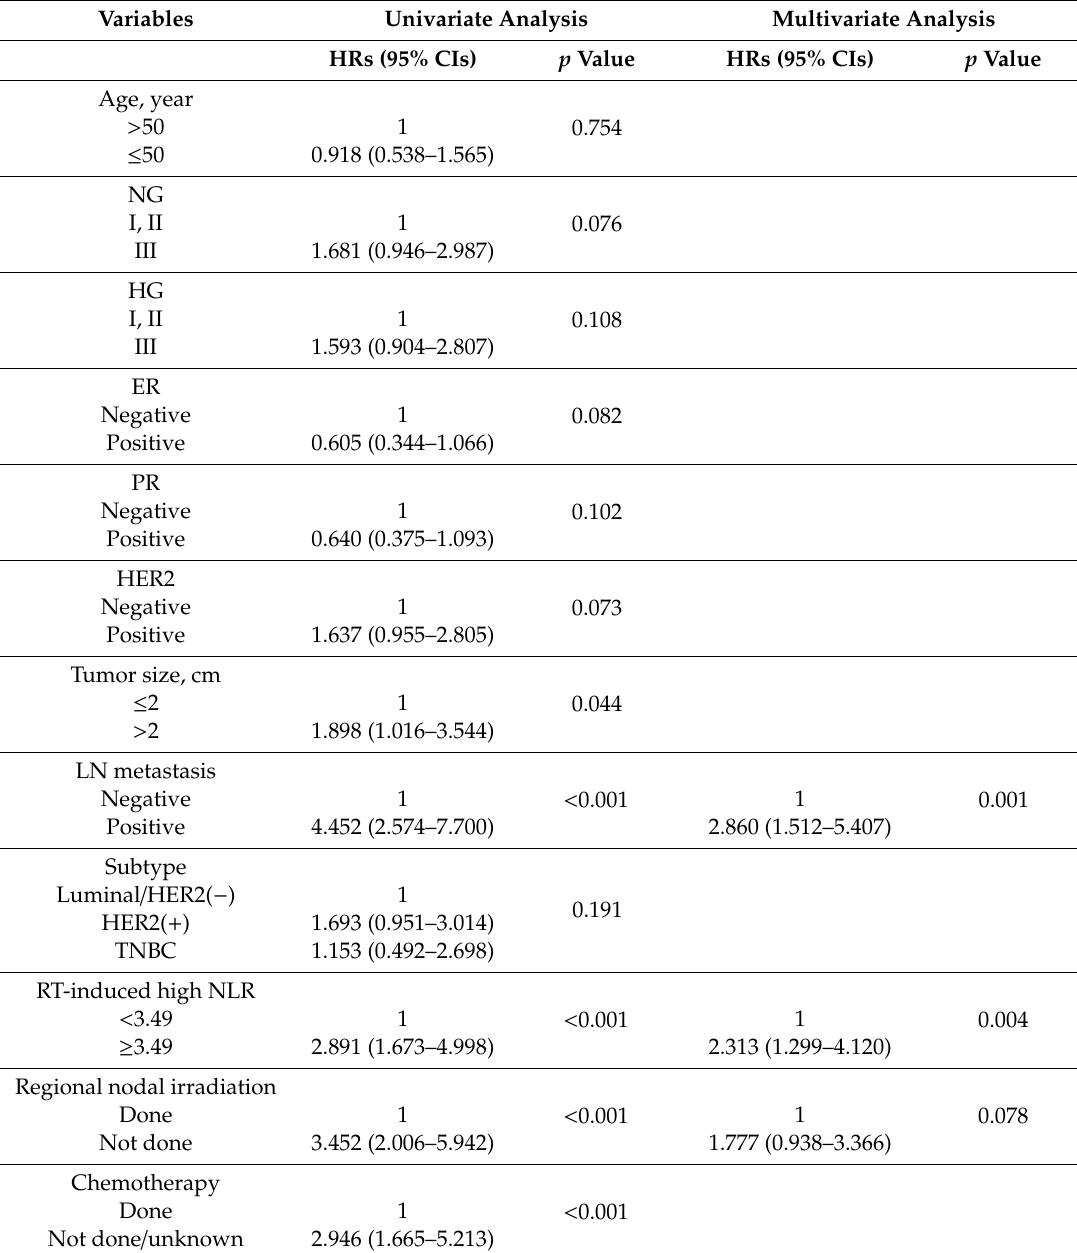
(Table S2; HR: 2.643, 95% CI: 1.335–5.236, p = 0.005) in the univariate analysis. Similar trends were seen in the multivariate analysis (Table S2; HR: 2.394, 95% CI: 1.106–5.181, p = 0.027). RT-induced high NLR was an independent prognostic factor along with lymph node metastasis for survival outcome. Table 3. The HRs and 95% CIs for distant metastasis free survival (DMFS) according to RT-induced high